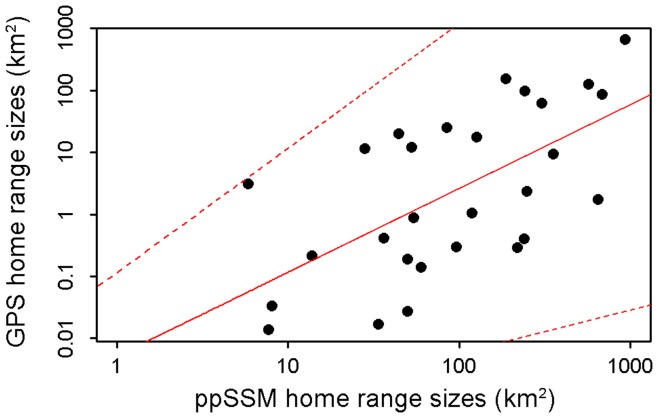
Logarithmic relationship between post-processed SSM and GPS home range sizes.The red solid line represents the best fit of a linear generalised linear model (a = 1.352, b = −2.287, adjusted r2 = 0.36), which had the most support (wAICc  = 0.66) amongst other polynomial candidate models. Red dashed lines represent the 2.5 and 97.5% confidence intervals.